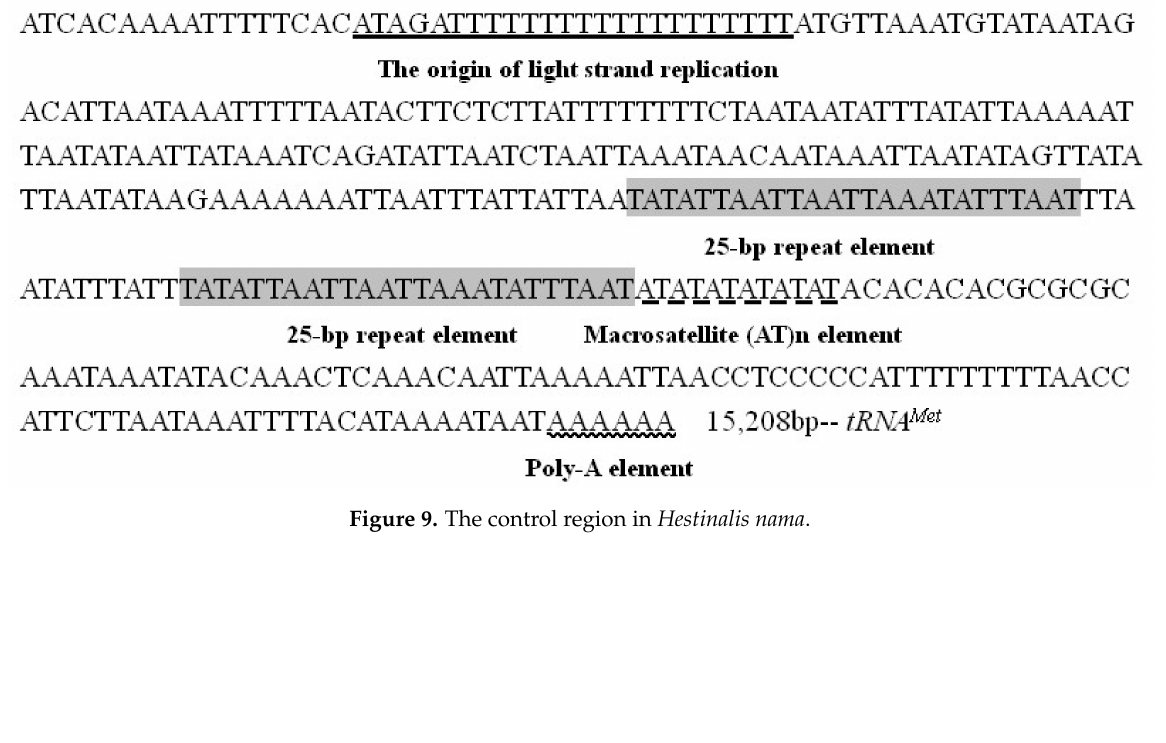
Figure 8. The control region in Hestina persimilis .